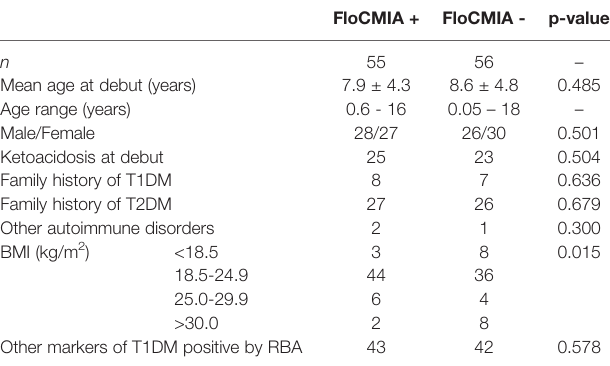
TABLE 1 | Clinical characteristics for two subsets of diabetic patients positive (n=55) or negative (n=56) by